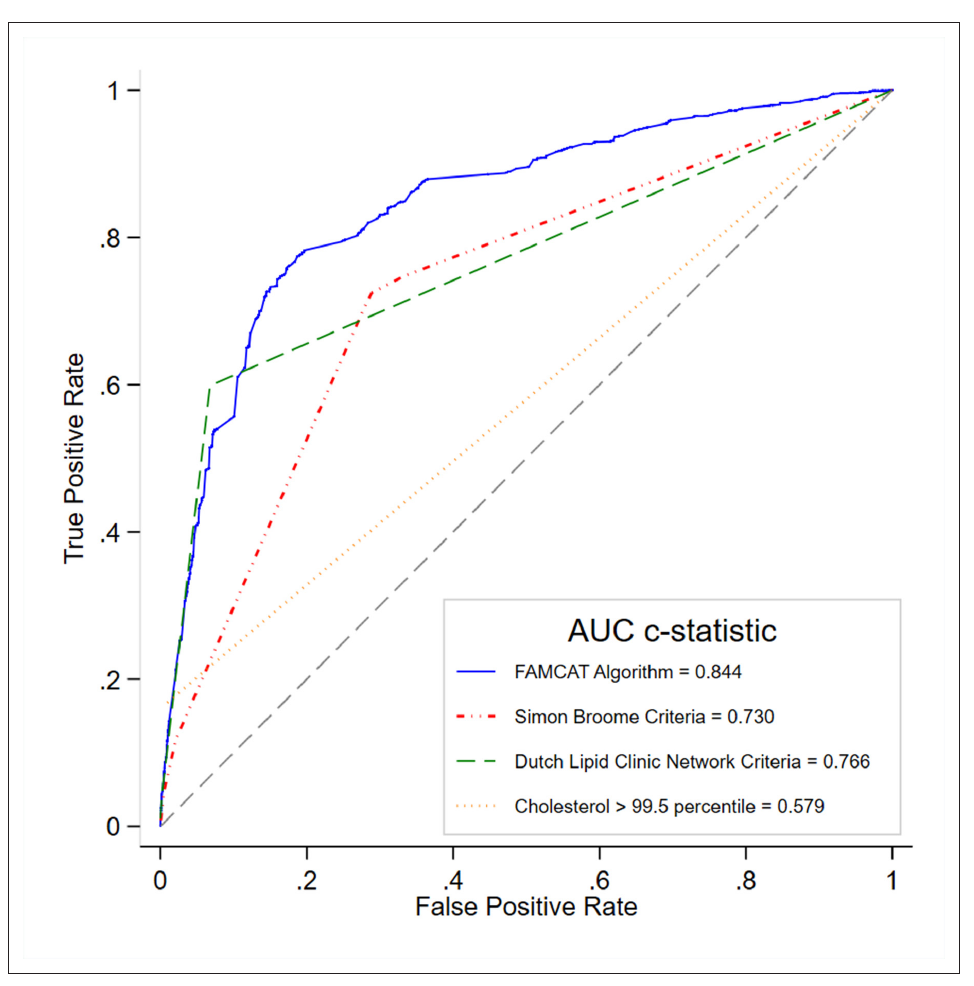
Figure 1 Receiver operating curves derived from the external validation cohort ( n = 1 030 183) for models of identifying familial hypercholesterolaemia in general practice (FAMCAT discrimination compared with recommended diagnostic criteria ). Higher area under the curve (c- statistic) confers better